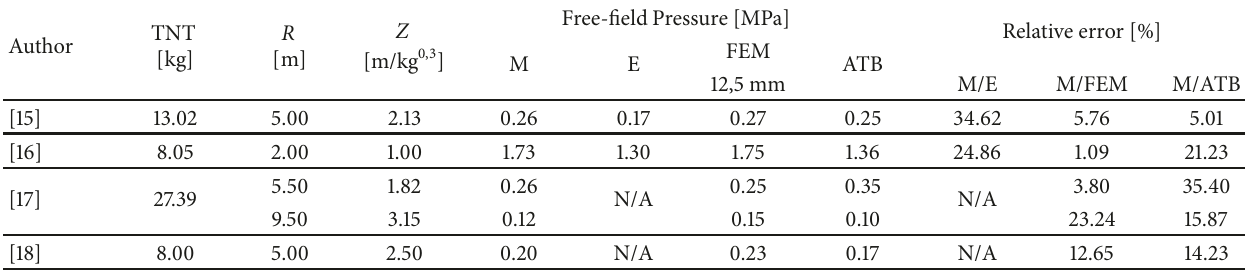
Table 13: Incident pressure comparison.